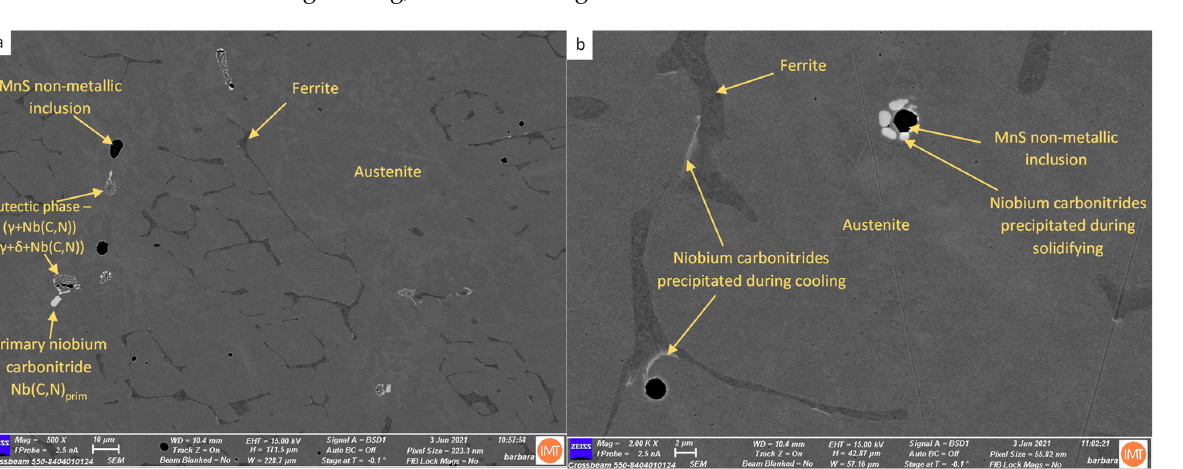
Figure 9. Backscattered electron image of MnS inclusion, niobium carbonitrides, and eutectic phase agglomerate in the austenite matrix in the 10Ni-70 steel sample, and EDS of Cr, C, Nb, and Mn. Figure 10 shows the EDS elemental mapping of complex MnS non-metallic inclusion. Small niobium nitrides precipitated near the δ / γ grain boundaries. As mentioned before, the white-stained belt of niobium nitride heterogeneously nucleated on MnS inclusion.